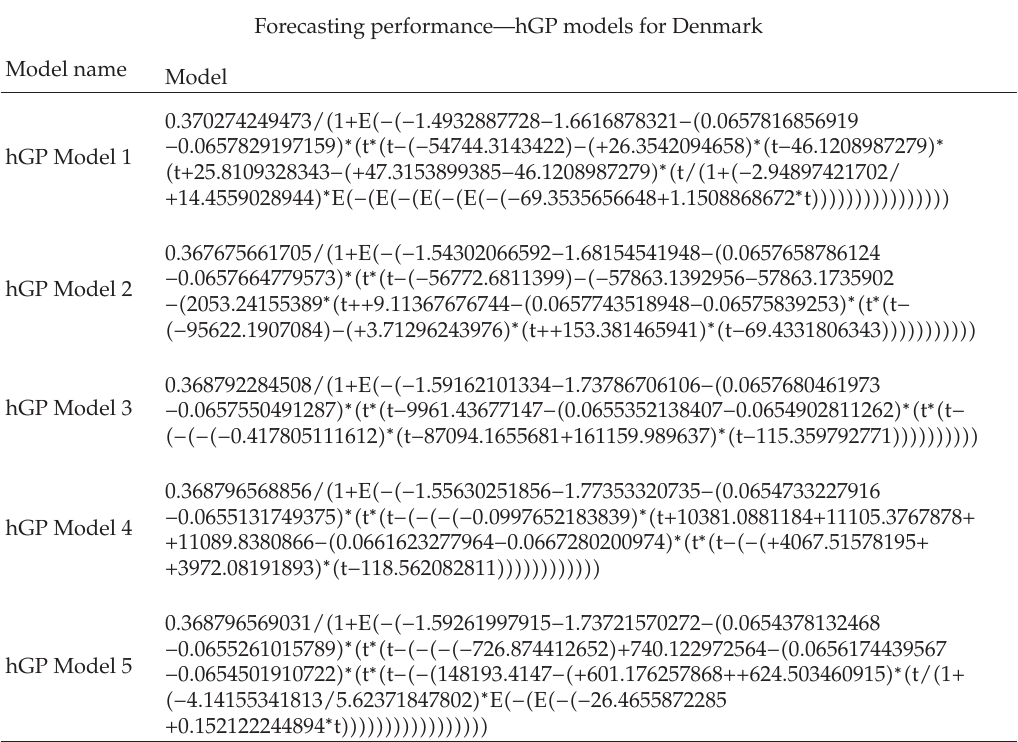
Table 35: Representation of the first five produced hGP models in forecasting (cid:2) Denmark (cid:3) . Forecasting performance—hGP models for Denmark